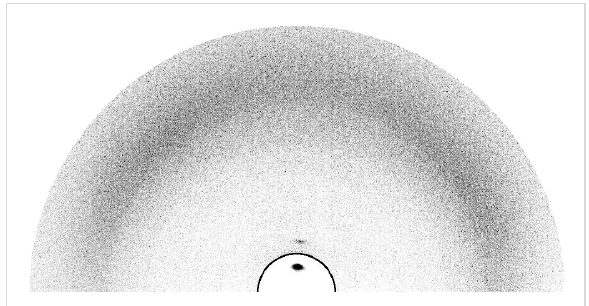
Figure 8: Grazing incidence X-ray pattern at 100 °C on the top of a 3 12 droplet, slowly cooled down from isotropic phase; for image contrast compatibility with the surrounding zone, intensities inside the zone, delimited by the black line and containing the first order reflection of the lamellar stacking, are divided by one hundred.